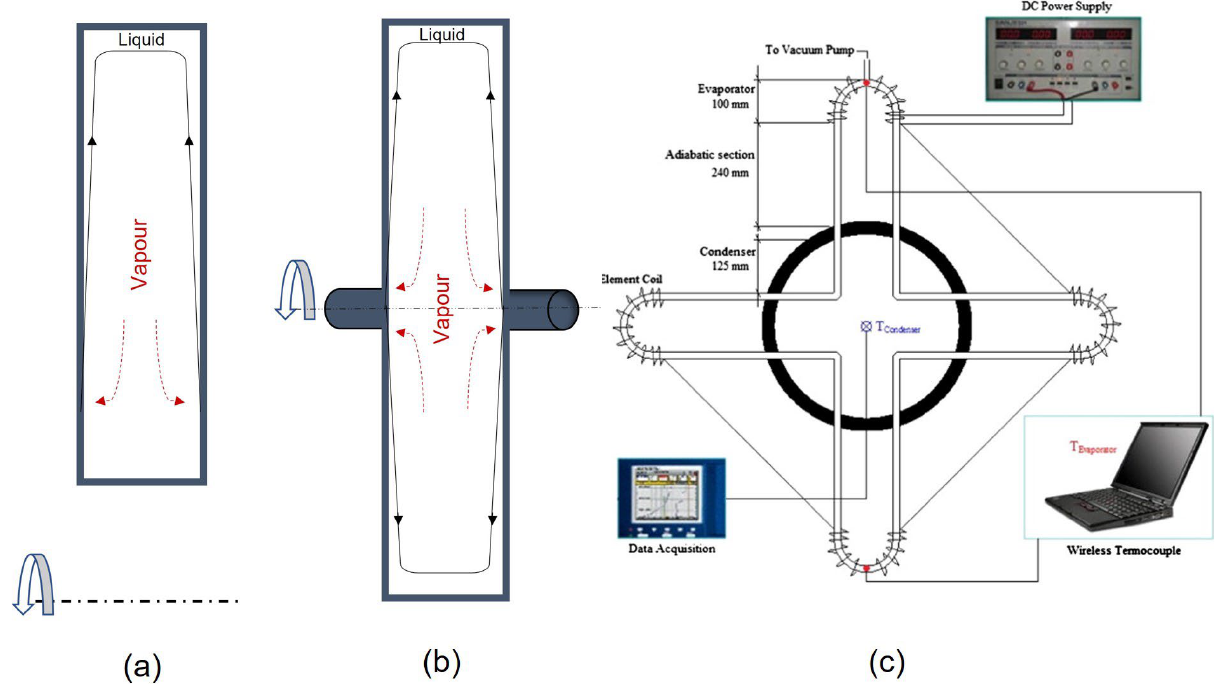
Figure 1. Variants of RRHPs: ( a ) conventional cylindrical RRHP; ( b ) disk-shaped RRHP [15]; ( c ) radial rotating pulsating heat pipes [16].